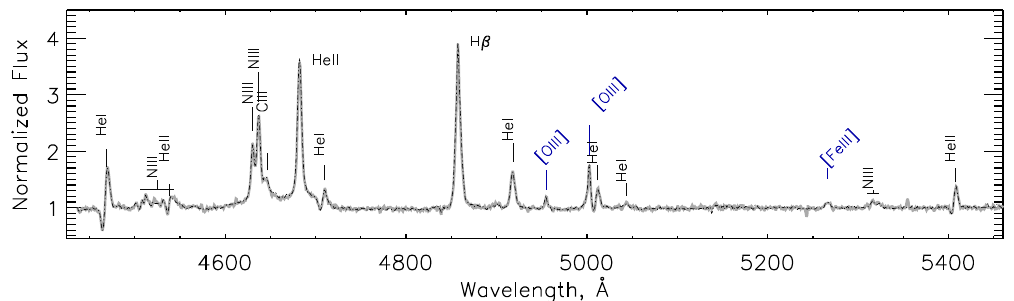
Figure 5. Comparison of normalised optical spectra of GR290 obtained with GTC/OSIRIS in July 2016 (grey thick line) and September 2018 (black dash-dotted line). Spectra are nearly identical.